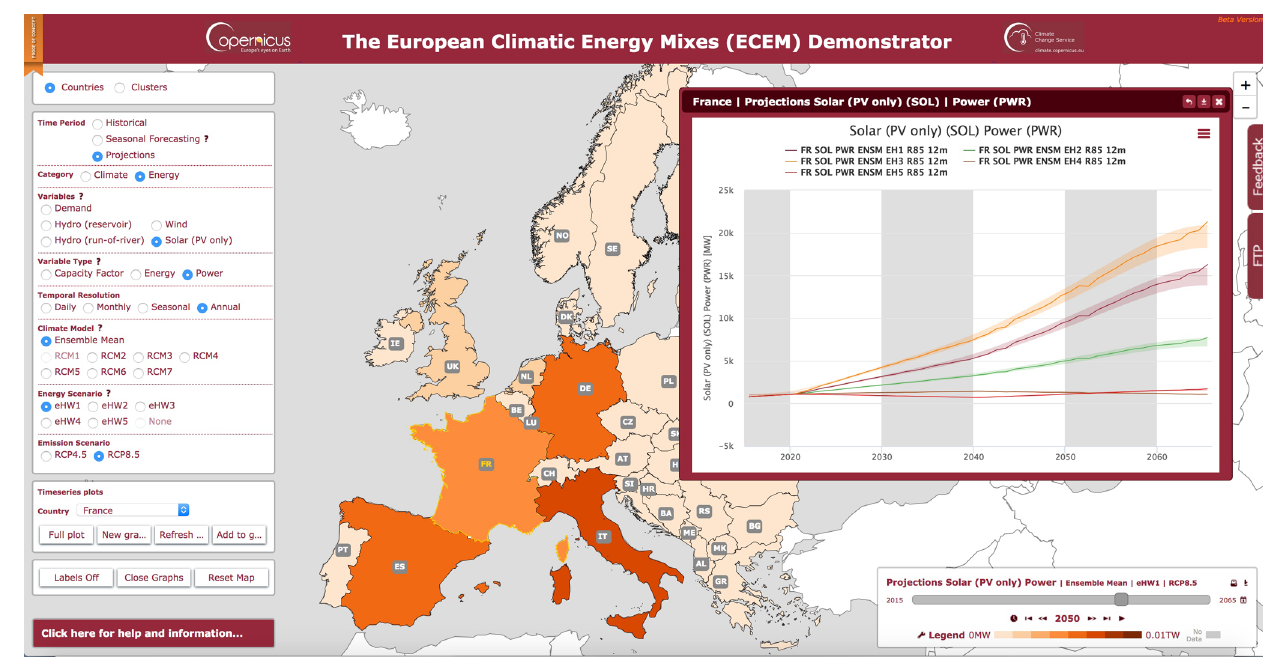
Figure 2. Screenshot of the C3S ECEM Demonstrator. It shows solar power for France for the projection period (RCP8.5) for the five e-Highway2050 scenarios described in the text (time series plot) and for Europe (underlying map) for year 2050 for the first e-Highway2050 scenario (purple line in the timeseries). Comprehensive documentation about the Demonstrator is available at the bottom left hand side of the Demonstrator (http://ecem.climate.copernicus.eu/demonstrator/, last access: 3 July